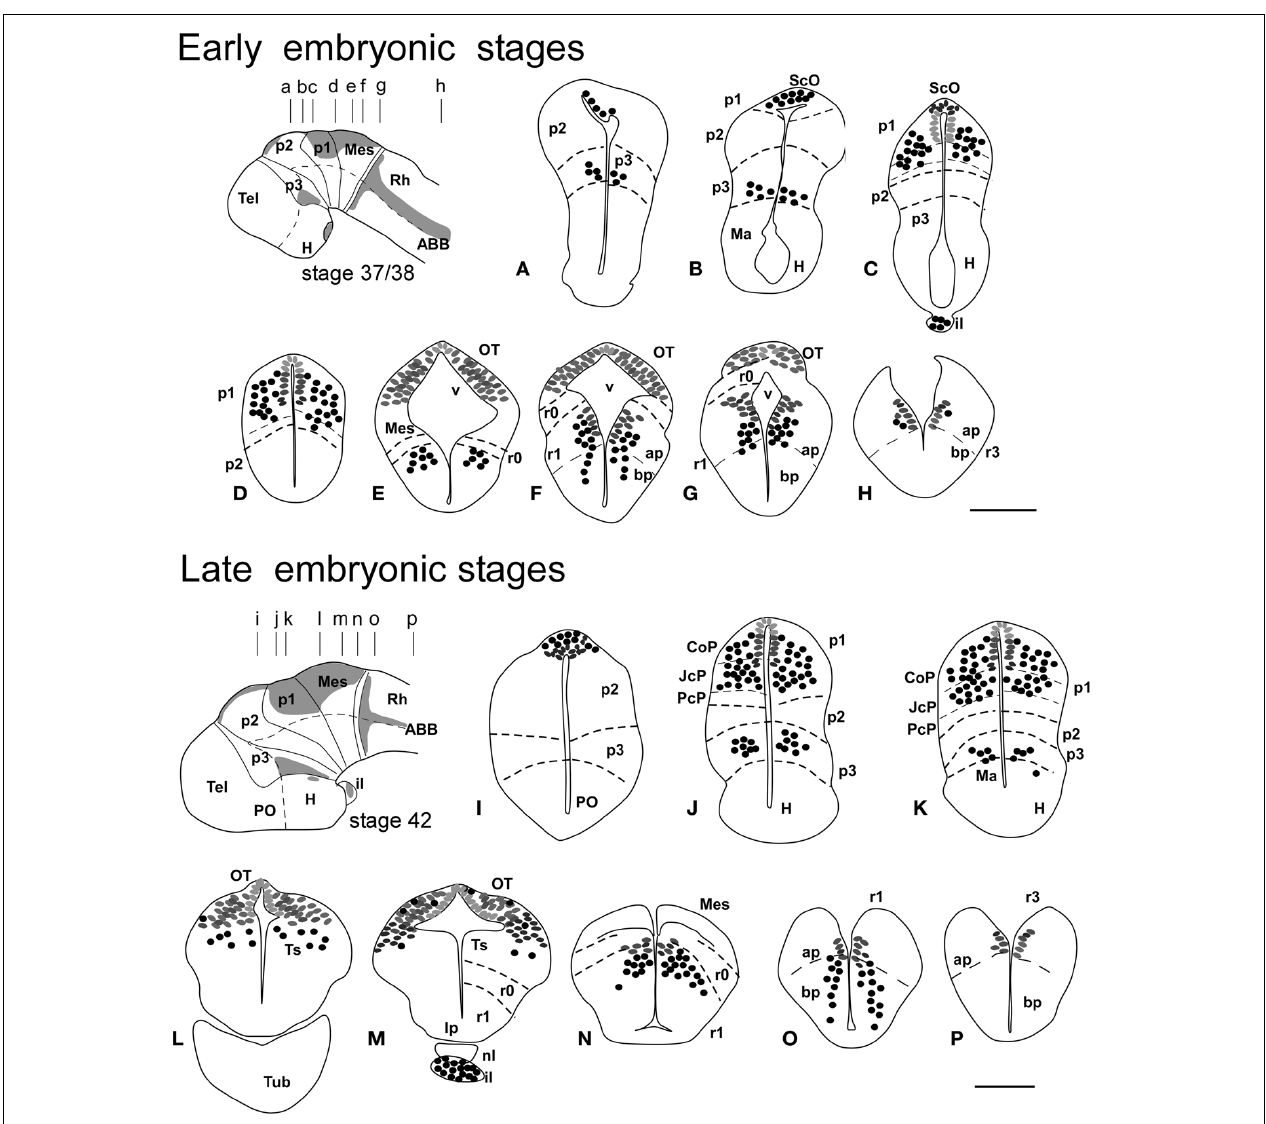
FIGURE 1 | Schematic drawings of transverse sections through the brain of Xenopus laevis at early embryonic stage 37/38 (A–H) and late embryonic stage 42 (I–P) showing the distribution of Pax7